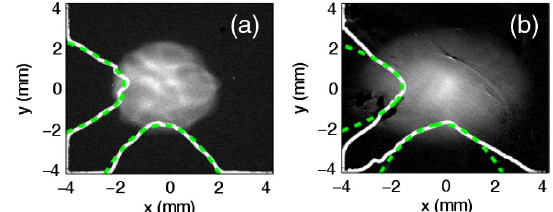
FIG. 8. Examples of measured spatial ð x; y Þ distribution and associated projections (white solid lines) with parabolic fit (green dash lines). Images (a) and (b) respectively correspond to the beam being photoemitted using the ultrashort Ti:Sp and the picosecond Nd:YLF laser systems. The beam density is measured at the Ce:YAG screen X6 (see Fig. 2) for Q ’ 250 (cid:5) 50 pC